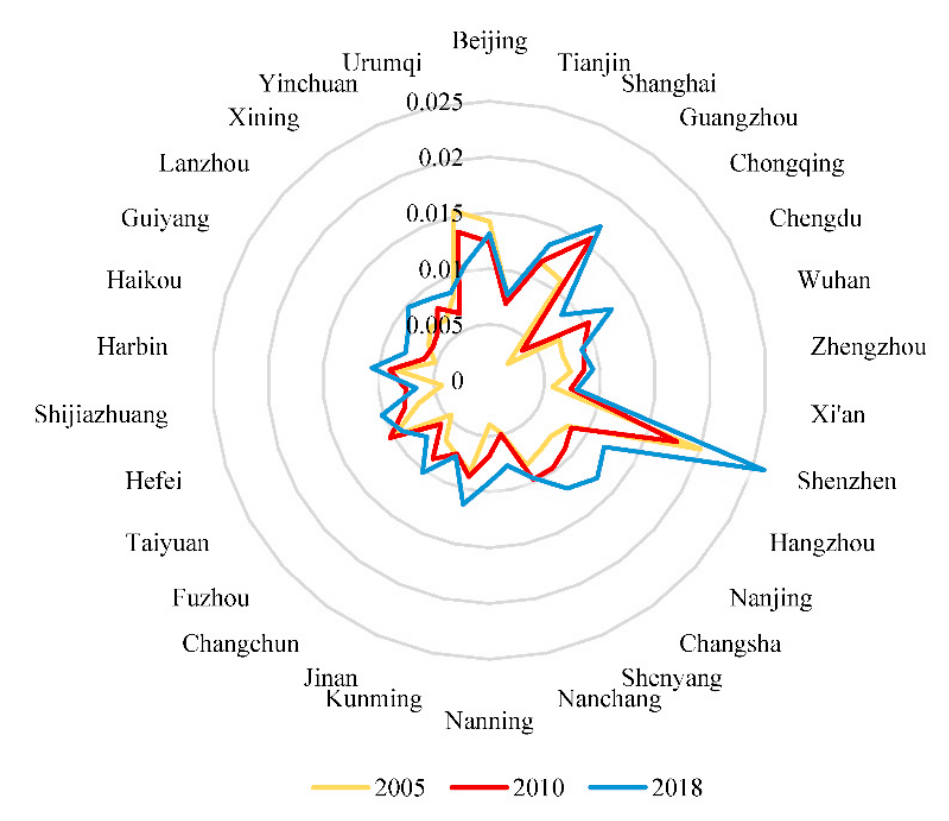
Figure 2. Urban public service levels of 30 large and medium-sized cities in China for the selected